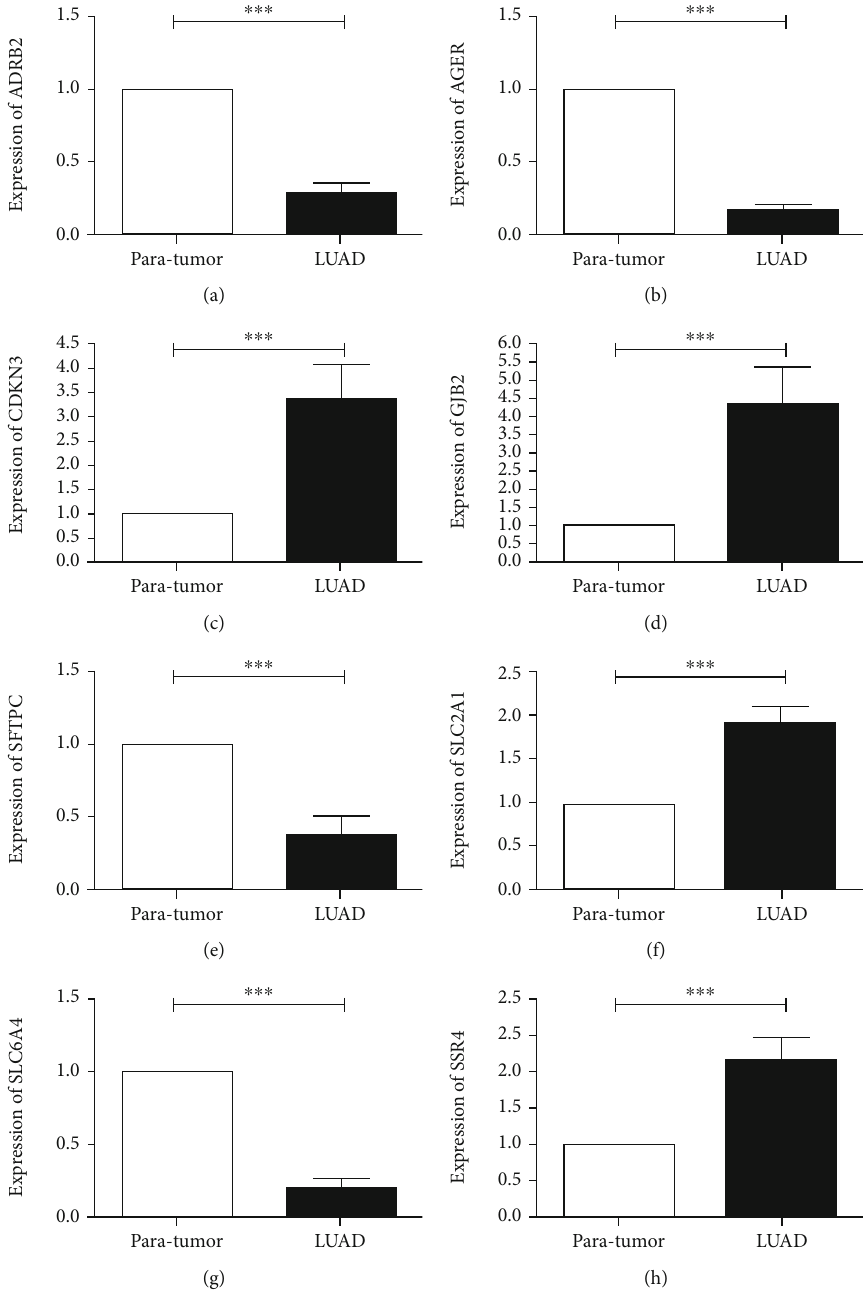
Figure 10: Veri fi cation of gene expression with clinical tissues. (a) ADRB2. (b) AGER. (c) CDKN3. (d) GJB2. (e) SFTPC. (f) SLC2A1. (g) SLC6A4. (h) SSR4. ∗ P < 0 : 05 , ∗∗ P < 0 : 01 , ∗∗∗ P < 0 : 001